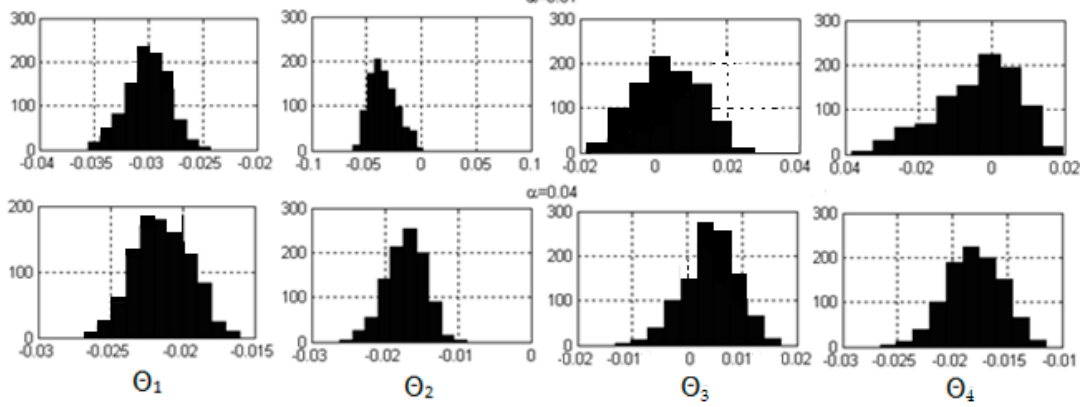
Figure 5. Distributions of estimations when four parameters are estimated.